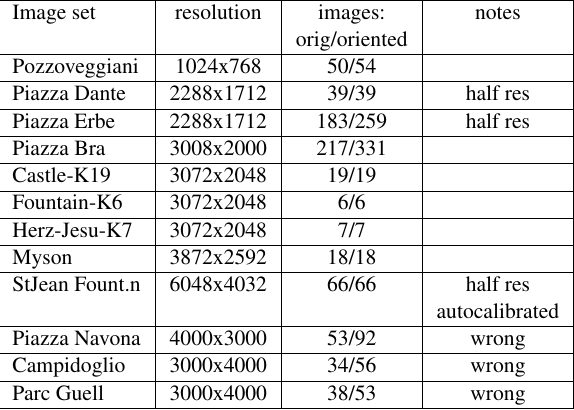
Table 2: Summary of